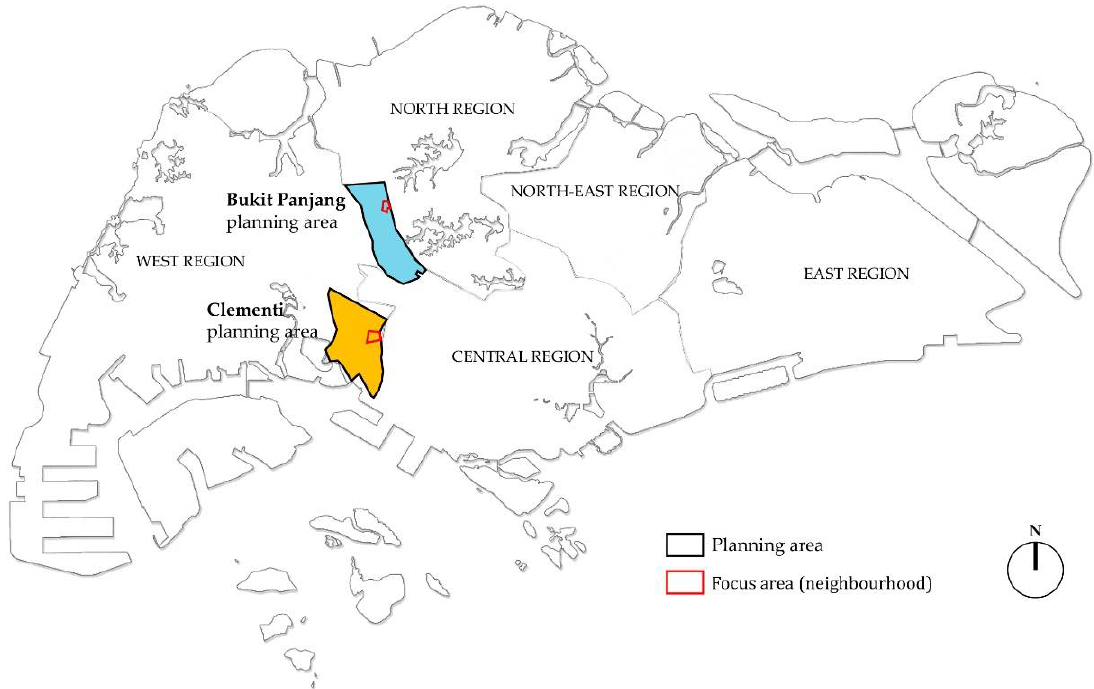
Figure 1. Location of study areas (source: by author).